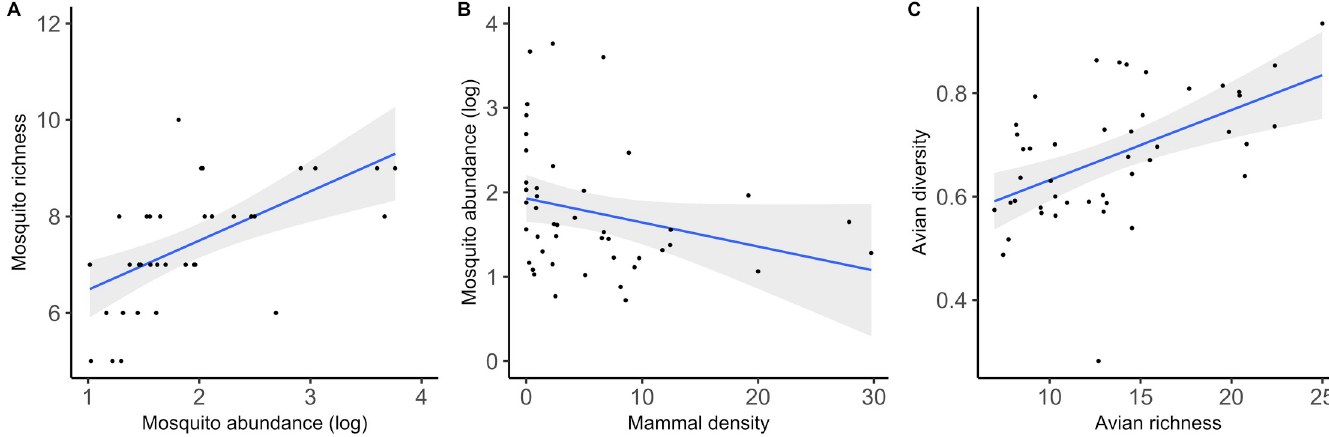
Fig 4. Relationships between A) mosquito richness (measured from a rarefaction curve) and the total number of mosquitoes collected; B) the number of mosquitoes collected and mammal density; and C) avian diversity (measured as the evenness index) and avian richness (estimated from a rarefaction curve) at the 45 localities included in this study. The 95% confidence level interval is shown in